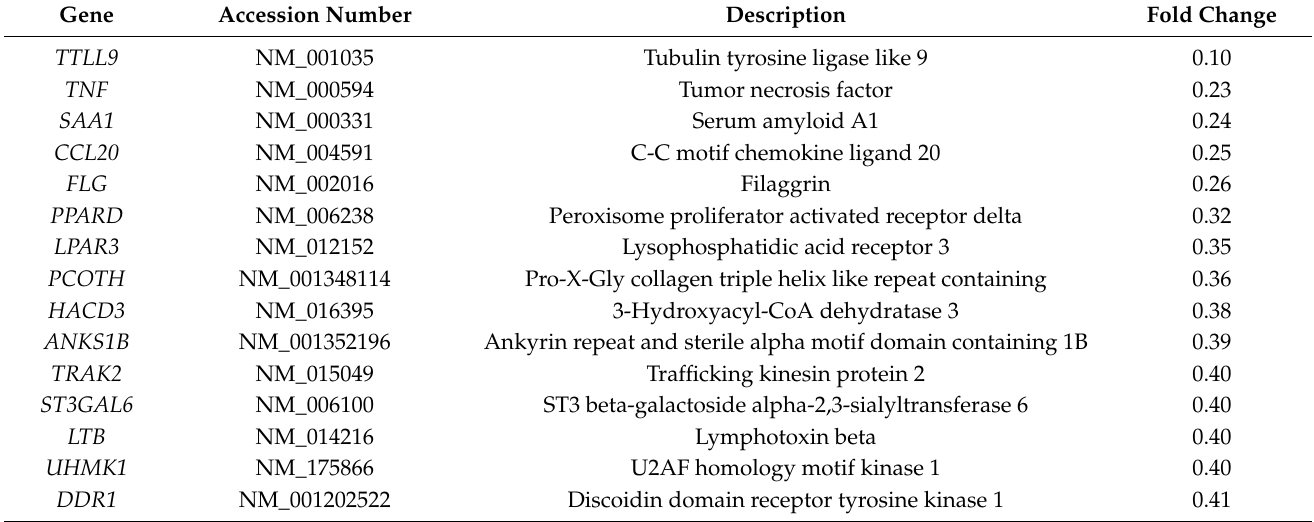
Table 2. Genes with expression decreased by PPARD knockdown ( ≤